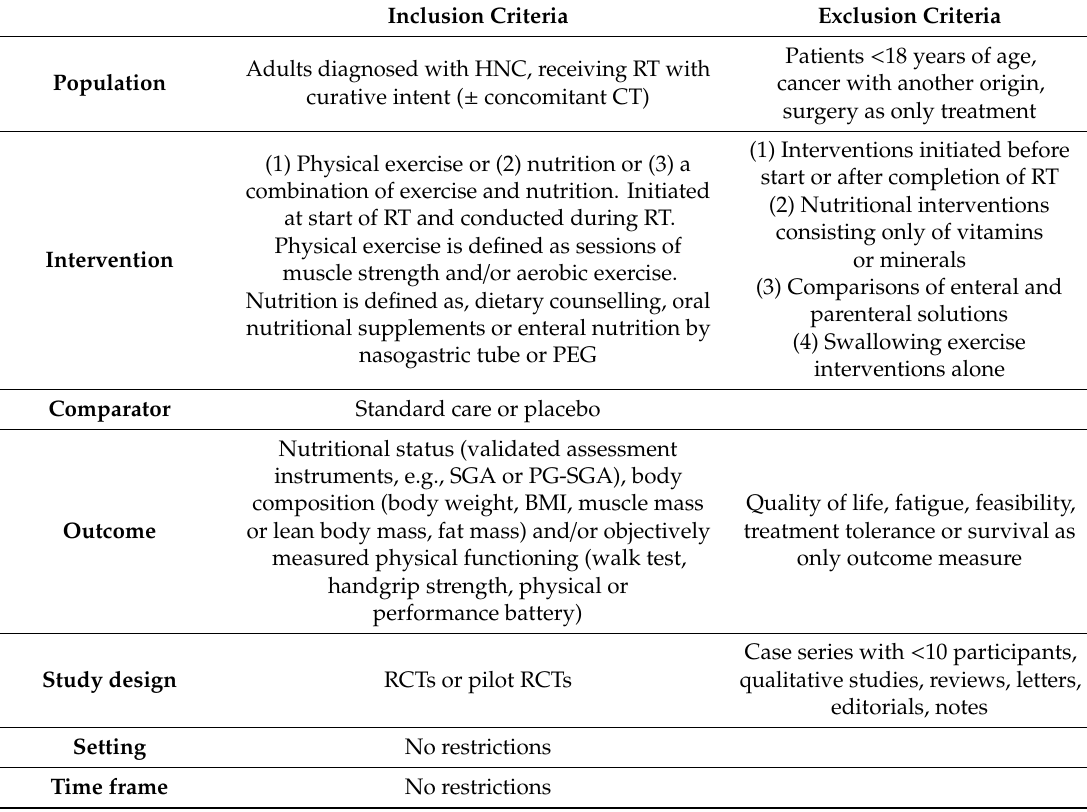
Table 1. PICOS (patients / population, intervention, comparator, outcomes, study design) criteria for inclusion and exclusion of